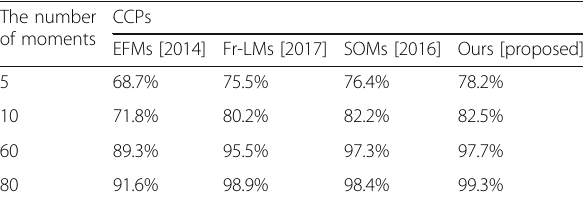
Table 5 Comparison our approach results with the published results in recent years for D2